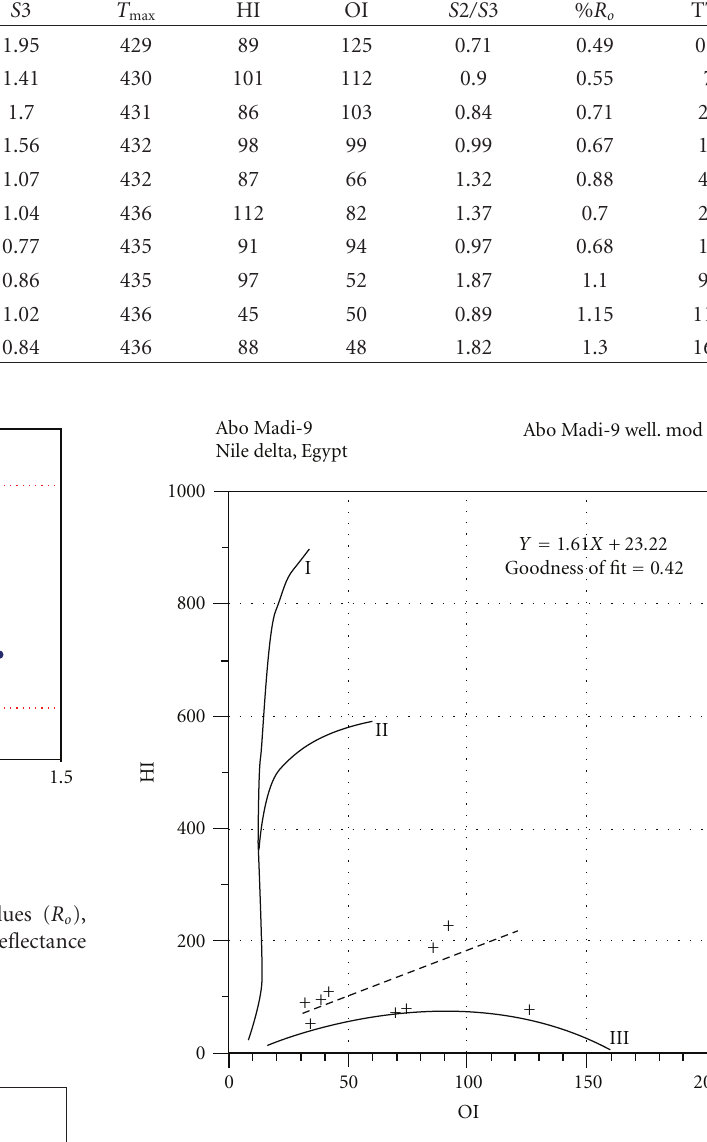
Figure 5: Plot of Oxygen index versus hydrogen index for the analyzed samples from Abu Madi-9